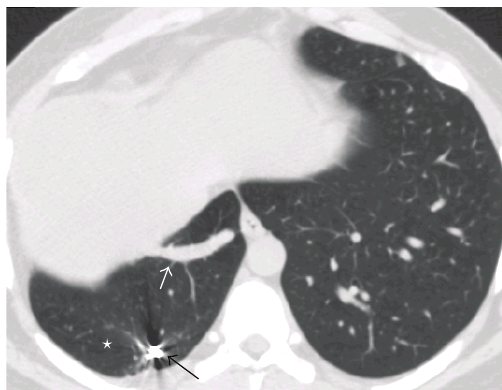
Figure 9: CT axial image depicts complete regression of the seques- tration at right posterobasal region (asterix), meandering right infe- rior pulmonary vein (white arrow). Artefact from the coil within one of the anomalous systemic artery (black arrow).